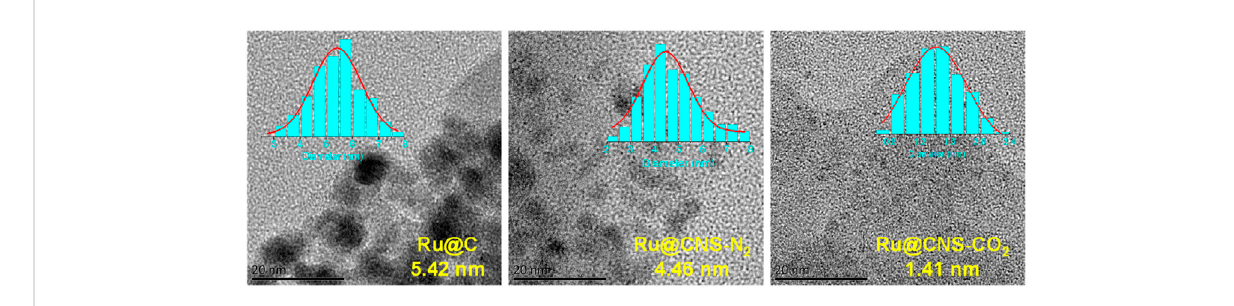
FIGURE 1 TEM images and histograms of particle size for the